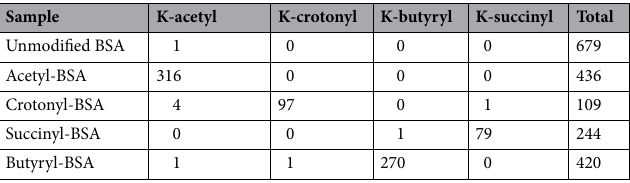
Table 1. Spectral counts of acyl-modifications in